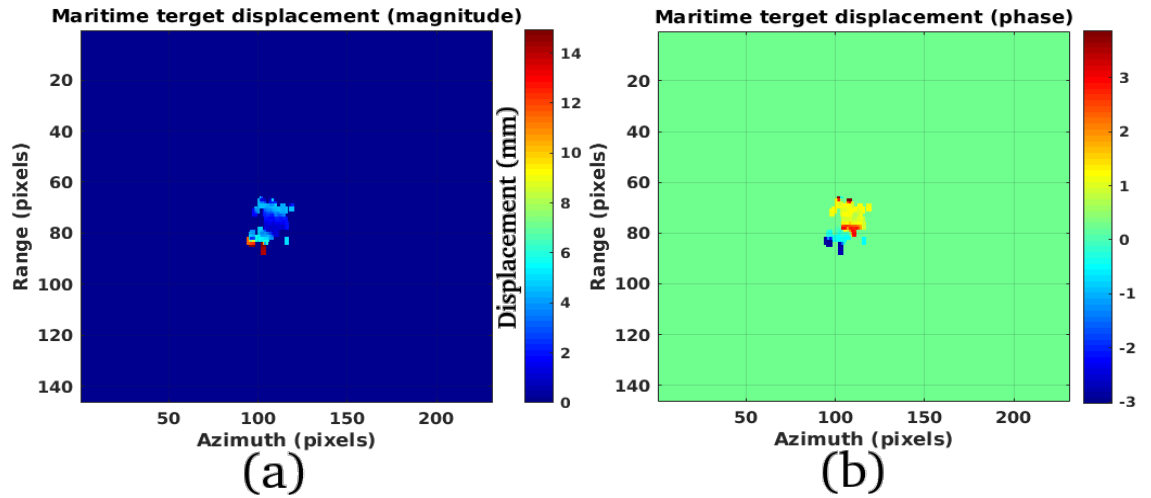
Figure 26. ( a ): Small ship displacement map (magnitude). ( b ): Small ship displacement map